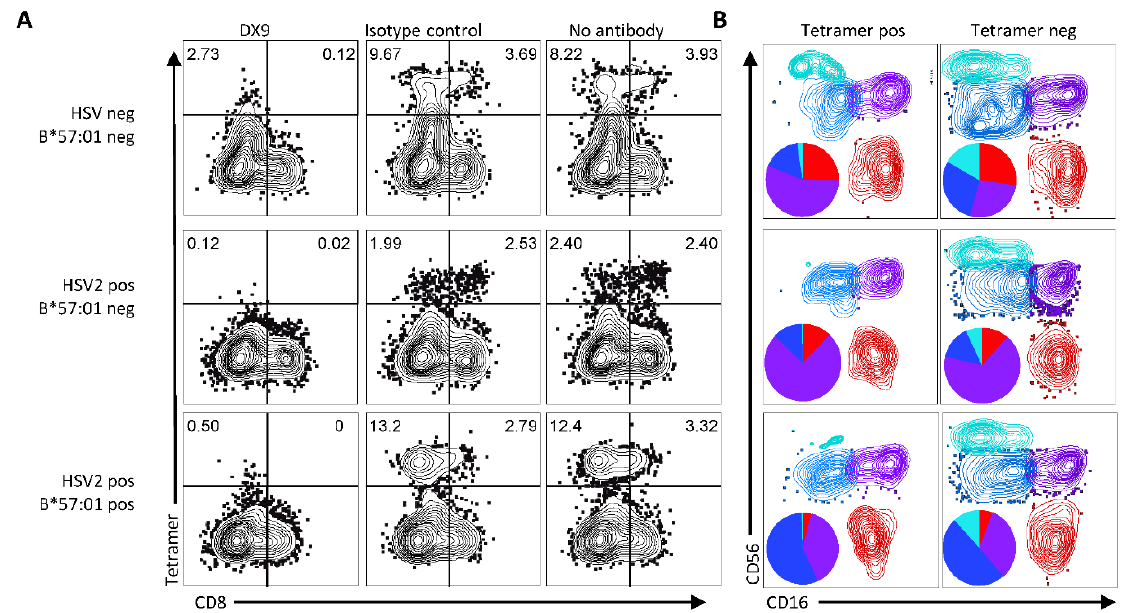
Figure 3. ( A ) B57-RTR tetramer binds gated NK cells in PBMC regardless of HLA type and HSV infection status in a KIR3DL1-dependent manner. Subject characteristics are displayed at left. Gating of NK cells as in Figure 2B. ( B ) Comparison of CD16 and CD56 expression between B57-RTR tetramer-positive and tetramer-negative NK cells from each donor. Contour plots show NK subpopulations of CD56 bright CD16 neg (light blue), CD56 dim CD16 neg/dim (dark blue), CD56 dim CD16 bright (purple), and CD56 neg CD16 bright (red) populations. Piecharts show relative proportions of each subpopulation within B57-RTR tetramer-positive or tetramer-negative NK cells in matching colors. Tetramer-positive NK cells had fewer CD56 bright CD16 neg NK cells (light blue) relative to tetramer-negative NK cells.